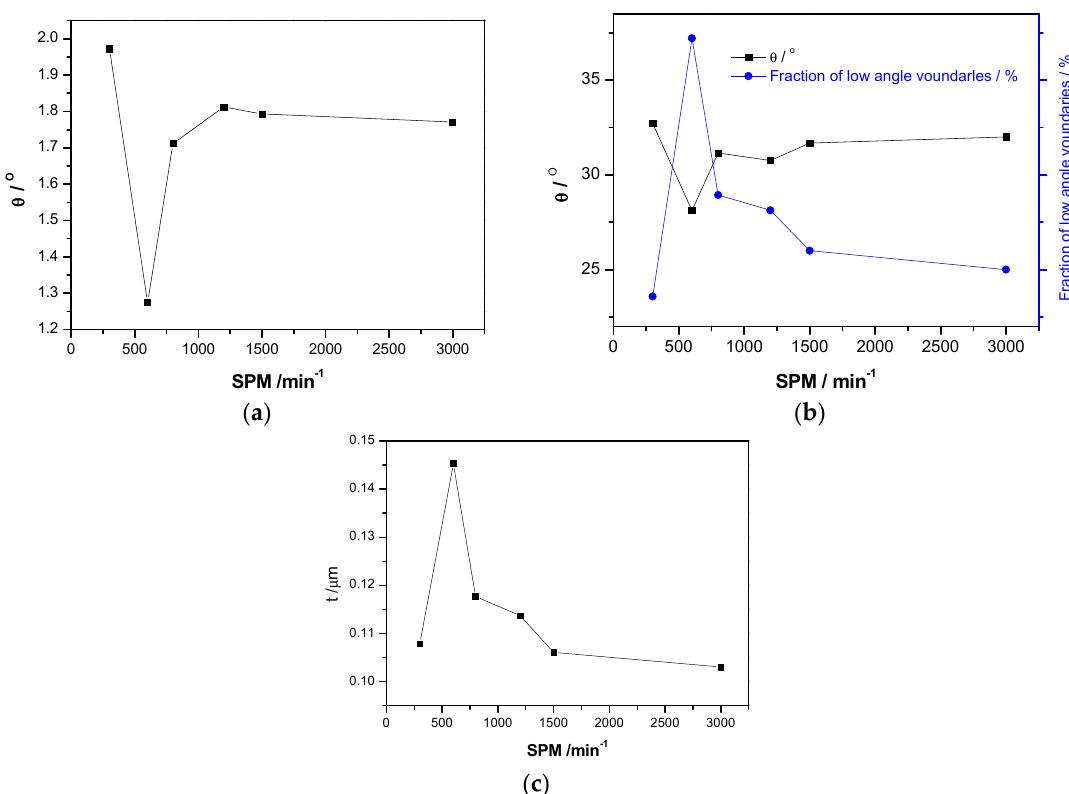
Figure 7. Electron back-scattered diffraction (EBSD) maps of the blanked edge prepared under different blanking speeds. ( a ) Local average orientation difference; ( b ) Grains misorientation; ( c ) Grain size.